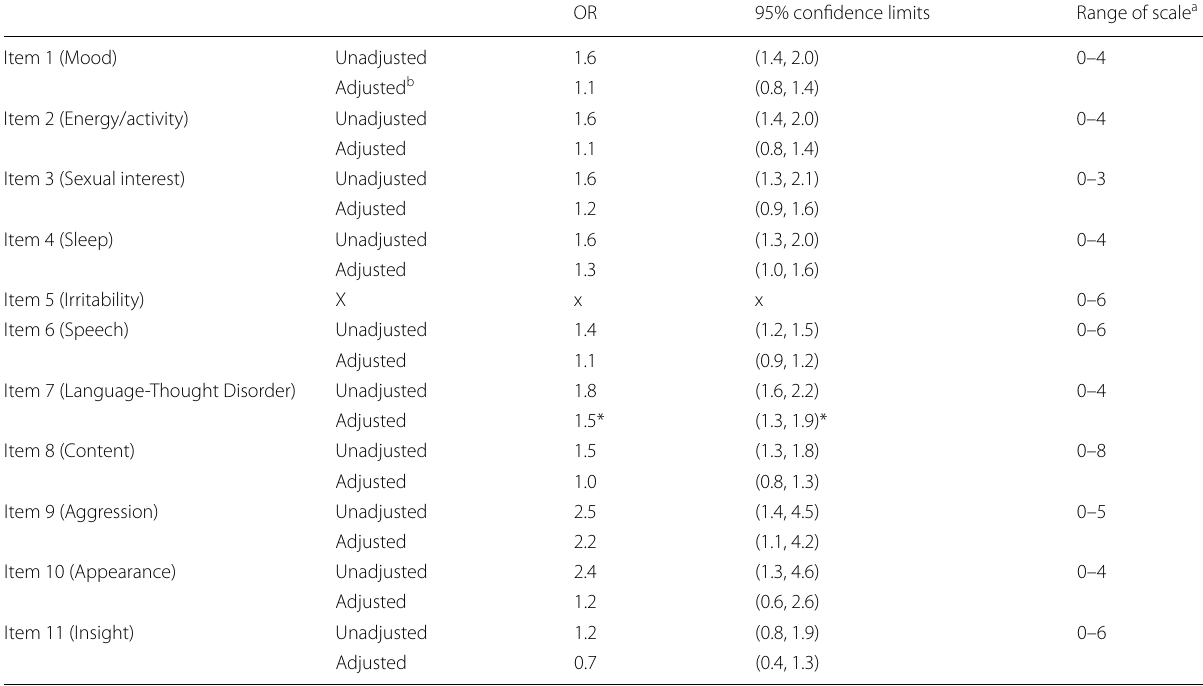
Table 5 Odds ratios of experiencing irritability depending on the different manic symptoms (YMRS items) during 849